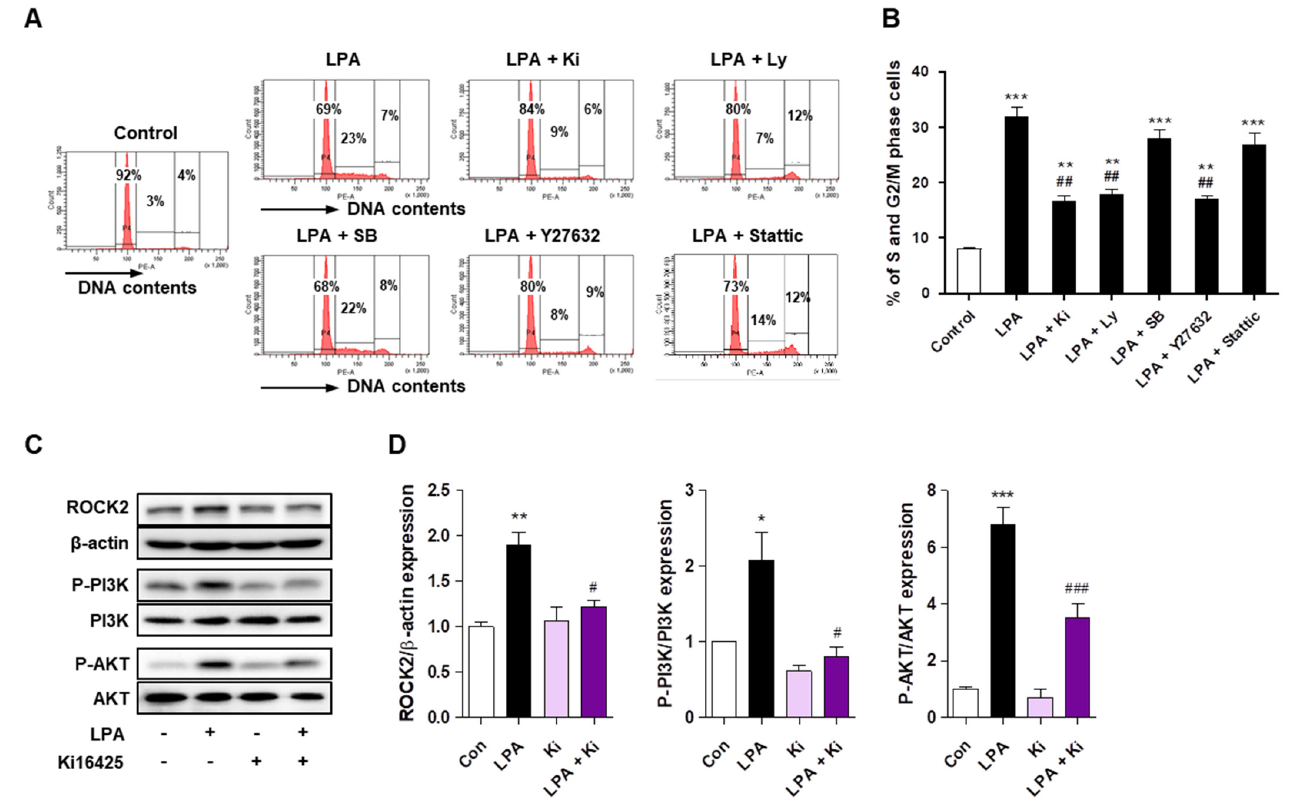
Figure 6. Lysophosphatidic acid (LPA) promotes the cell cycle progression through ROCK2 and PI3K/AKT signaling in HaCaT cells. ( A , B ) HaCaT cells were pretreated with Ly294002 (Ly; 10 µ M), SB203580 (SB; 10 µ M), Y27632 (1 µ M), or Stattic (10 µ M) for 1 h, and subsequently treated with 10 µ M LPA for 24 h, or cells were treated with 10 µ M LPA and 10 µ M ki16425 simultaneously for 24 h. Cell cycle phase distribution was analyzed using flow cytometry after staining with propidium iodide for measurement of the cellular DNA content. ( A ) The values in the representative flow cytometry histograms indicate the percentages of cells in G0/G1, S, and G2/M phases of the cell cycle, in that order. ( B ) The percentage of cells in the S and G2/M phase was calculated as the sum of each phase from ( A ). ( C , D ) The cells were treated with 10 µ M LPA in the presence or absence of 10 µ M ki16425 for 30 min (for ROCK2 and p-PI3K) and 60 min (for p-AKT). The protein levels of ROCK2, p-PI3K, and p-AKT were analyzed by Western blotting, quantified using ImageJ software, and normalized to those of β -actin, total PI3K, and total AKT, respectively. ( C ) Representative images of the blots and ( D ) relative densitometric bar graphs are shown. The data are presented as the mean ± standard error of the mean (SEM) of results obtained from three independent experiments. * p < 0.05, ** p < 0.01, *** p < 0.005 vs. Con; # p < 0.05, ## p < 0.01, ### p < 0.005 vs.